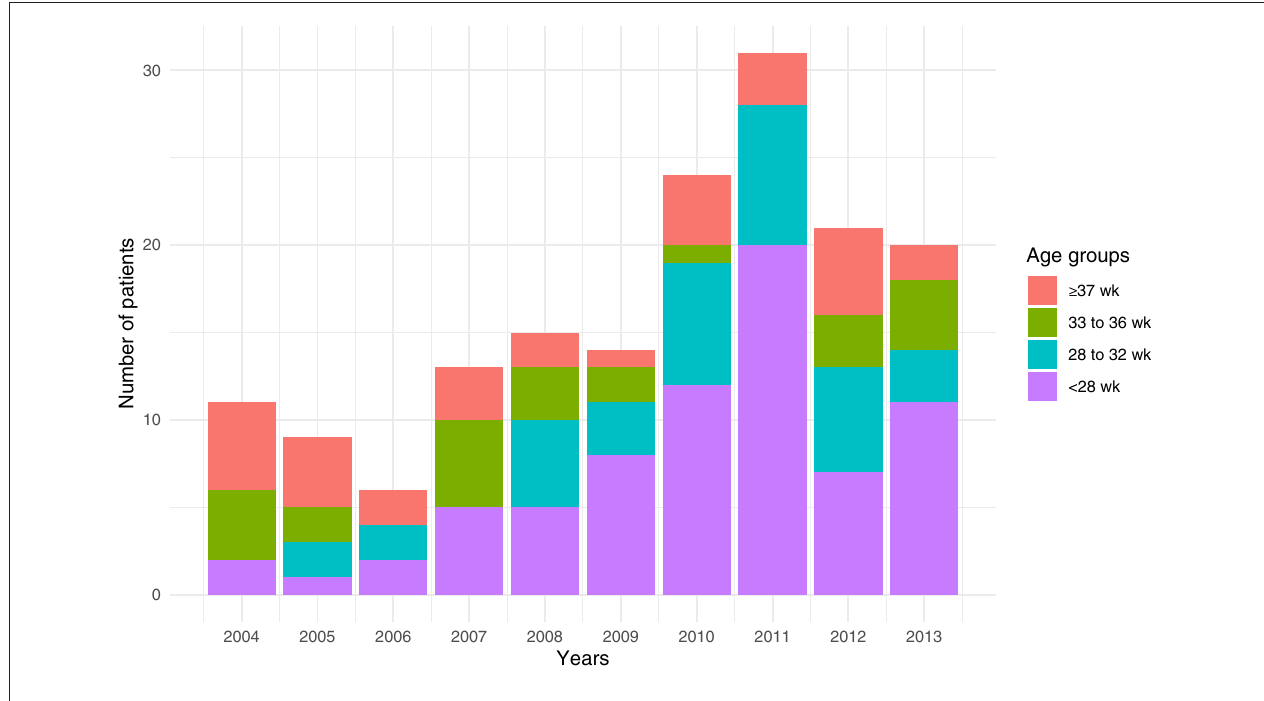
FIGURE 3 | Gestational age distribution per year of inclusion. wk,